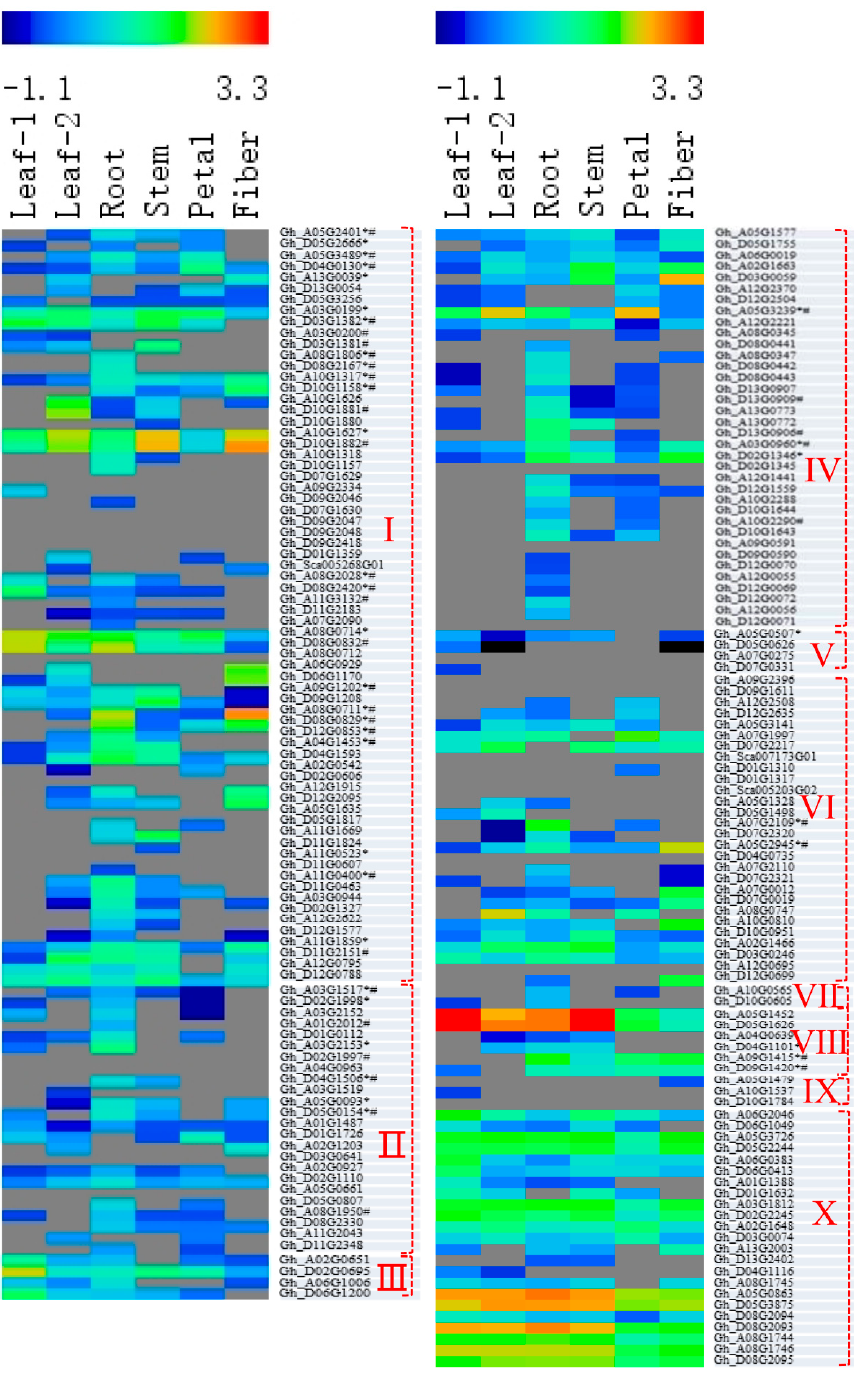
Figure 5. Expression profiles of POD genes across different cotton tissues. Values are log 10 FPKM . * the POD protein was detected in the field cotton xylem sap; # the POD protein was detected in the greenhouse cotton. Sources of the samples are as follows: leaf-1 (true leaves, Accession: SRX849561); leaf-2 (leaves at 2-week-old plants, Accession: SRX797901); root (roots at 2-week-old plants, Accession: SRX797899); stem (stems at 2-week-old plants, Accession: SRX797900); petals (petals of mature flowers, Accession: SRX797903); fibers (fibers of 25 days post-anthesis).